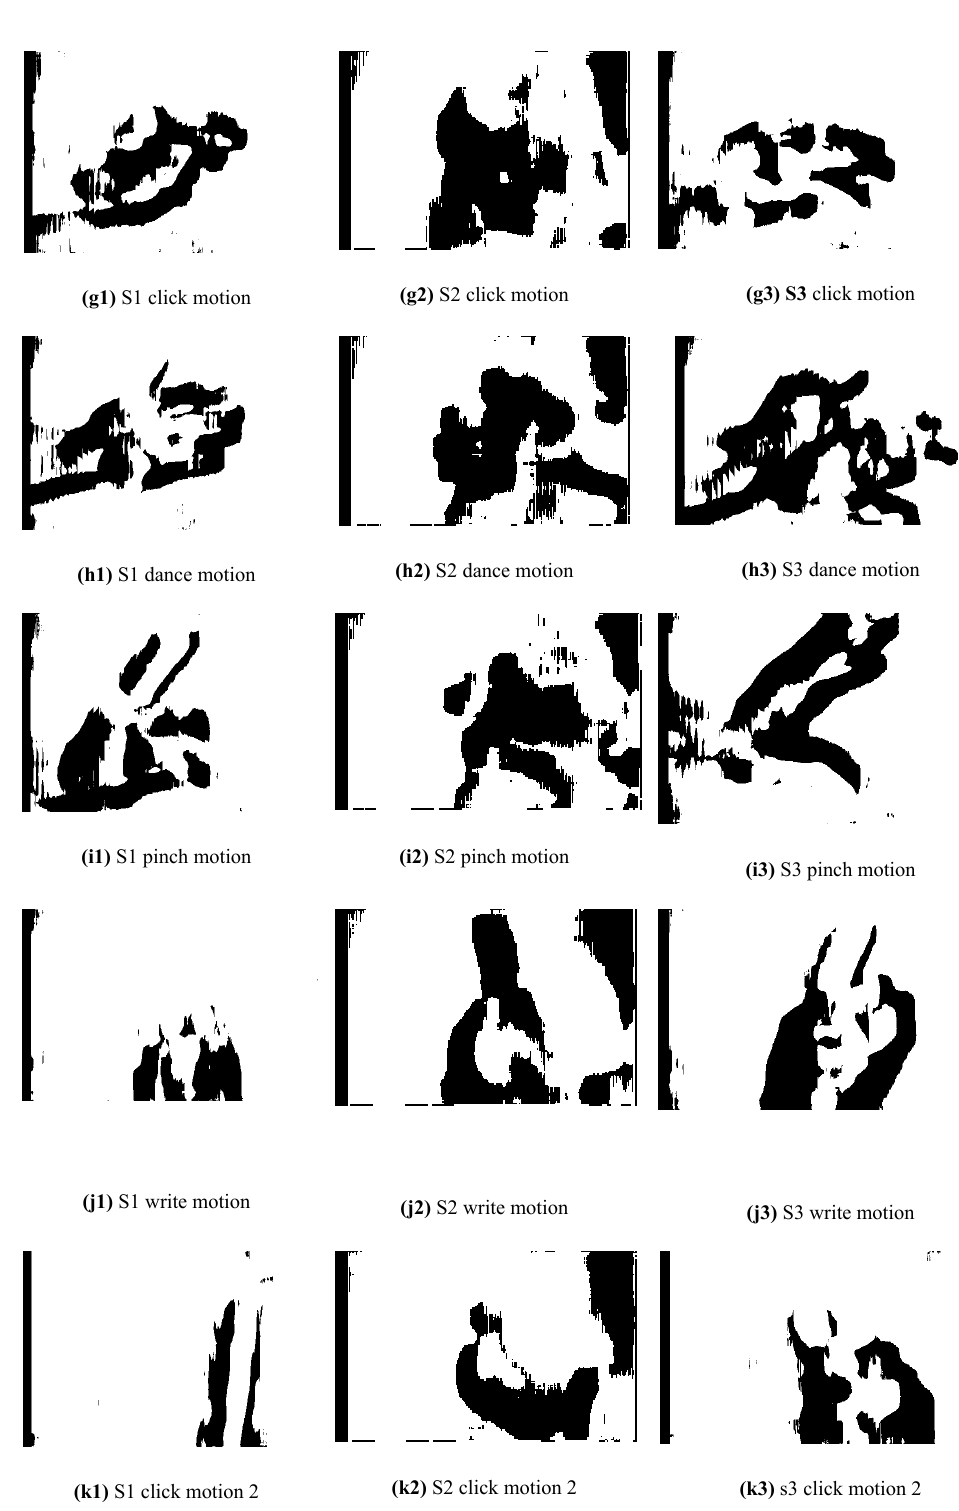
Figure A1. The disparity of Subjects 1, 2 and 3 images.